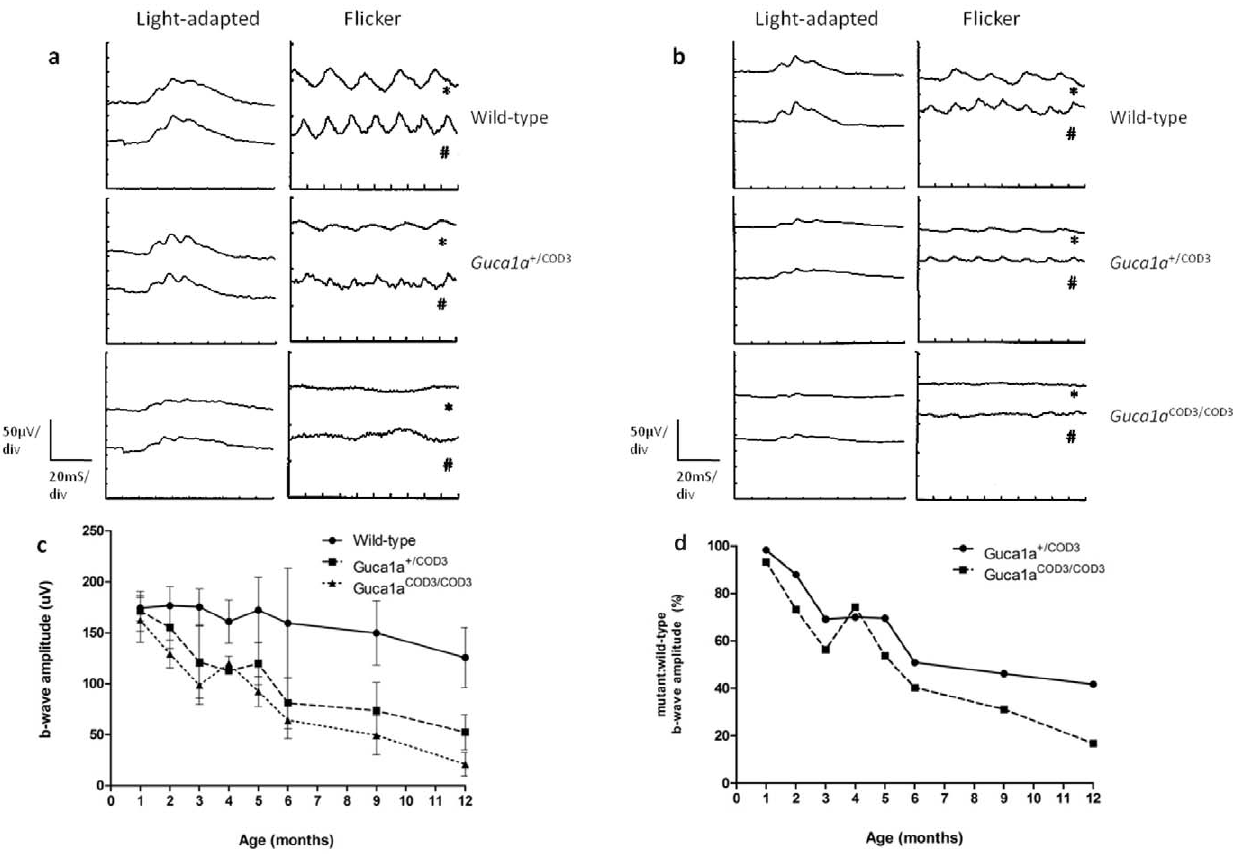
Figure 3. Electroretinography of Guca1a COD3 ‘knock-in’ mice. ( a ) Representative ERG traces recorded at five months of age. Light-adapted, cone-mediated ERG (upper trace, right eye, lower trace, left eye) is reduced in Guca1a + /COD3 and Guca1a COD3/COD3 mice compared to wild-type littermates, as is the cone-mediated flicker response to 10- and 15-Hz stimuli (* and # respectively). ( b ) Representative ERG traces recorded at 12 months of age. There is a greater reduction in cone function in mutant mice, with light-adapted flash responses further attenuated and flicker responses almost extinguished. ( c ) Averaged photopic, cone-mediated b-wave amplitudes from wild-type, Guca1a + /COD3 and Guca1a COD3/COD3 mice recorded over a twelve month period from birth. There is a progressive loss of cone function over time in both heterozygous and homozygous mutant mice compared to wild-type littermates ( n=8 per genotype). ( d ) ERG b-wave amplitudes from Guca1a + /COD3 and Guca1a COD3/COD3 mice plotted as a percentage of wild-type amplitudes over a twelve month period from birth.